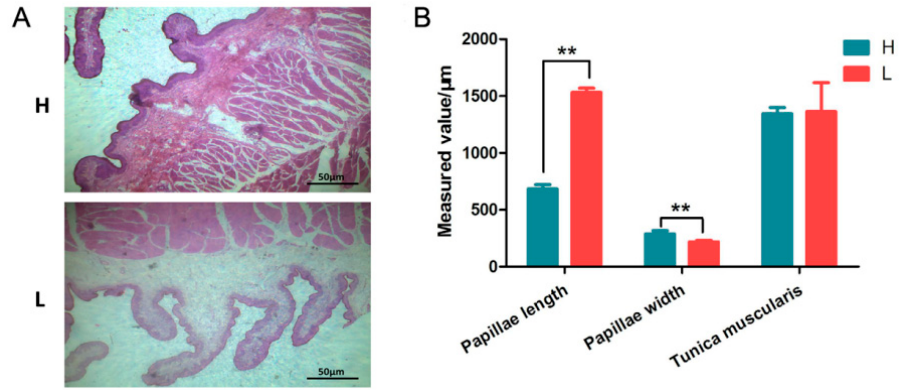
Figure 1. Histological observation of calf rumen tissues (n = 3). ( A ) Histological section of rumen tissues, H and L groups. ( B ) Quantification of papillae length and width, and the thickness of the tunica muscularis.